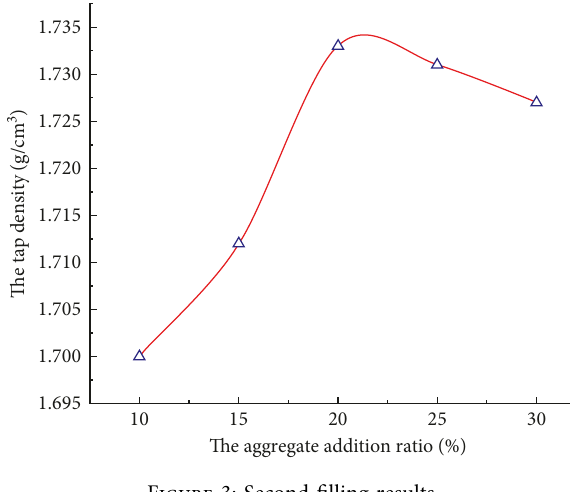
Figure 3: Second filling